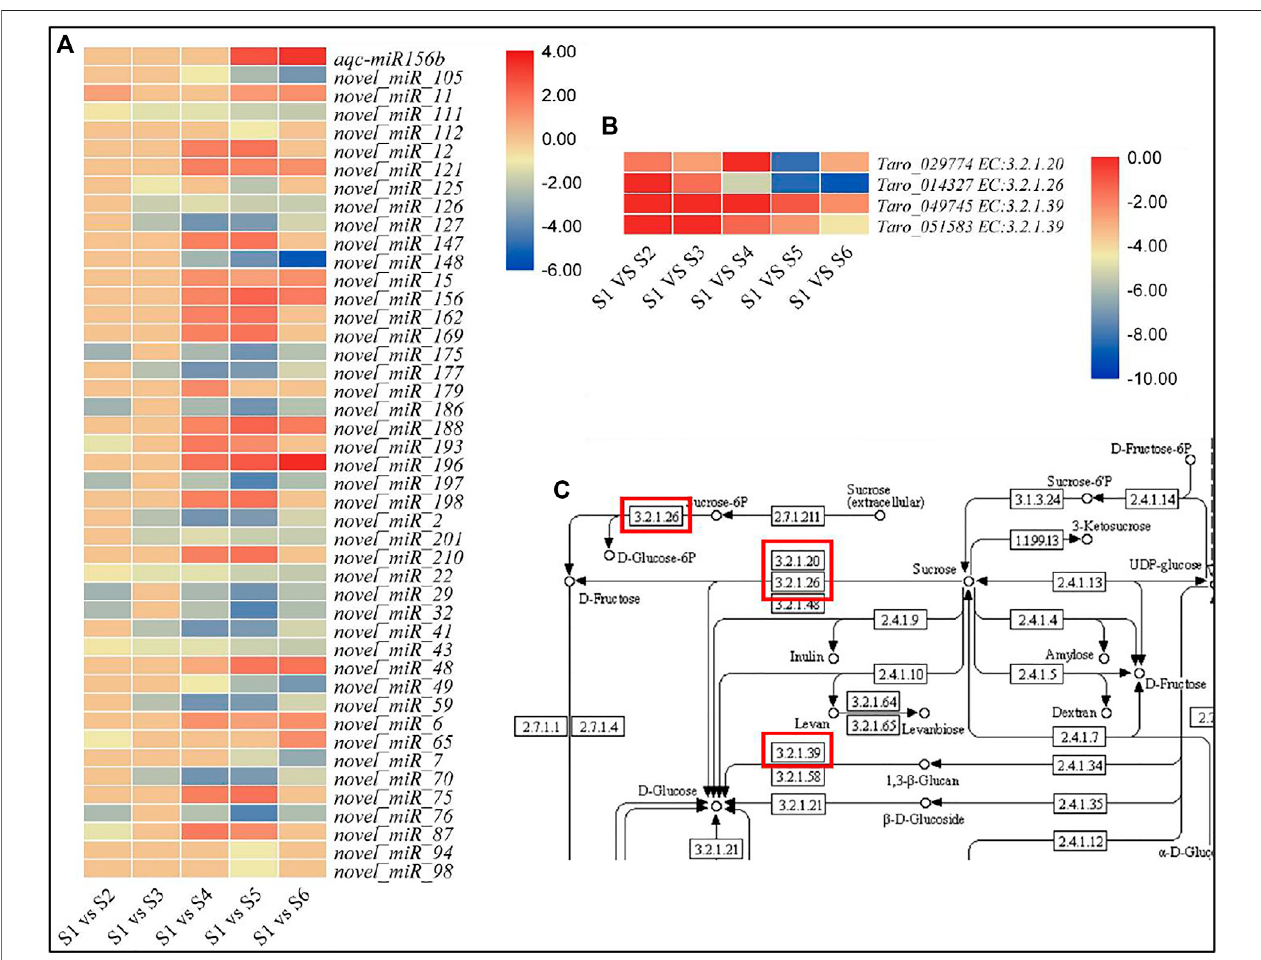
FIGURE 7 | Expression pro fi les of miRNAs. (A) miRNAs expressed in pairwise comparisons of growth stages. (B) Expression pro fi les of selected miRNA target genes. (C) Starch and sucrose metabolisms pathway representing enzymes identi fi ed as the targets of selected miRNAs.